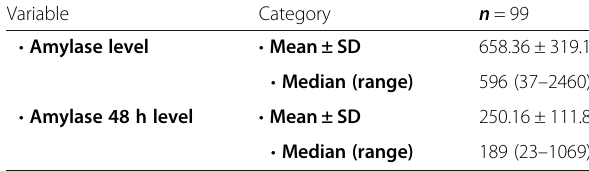
Table 4 Amylase level of the studied sample